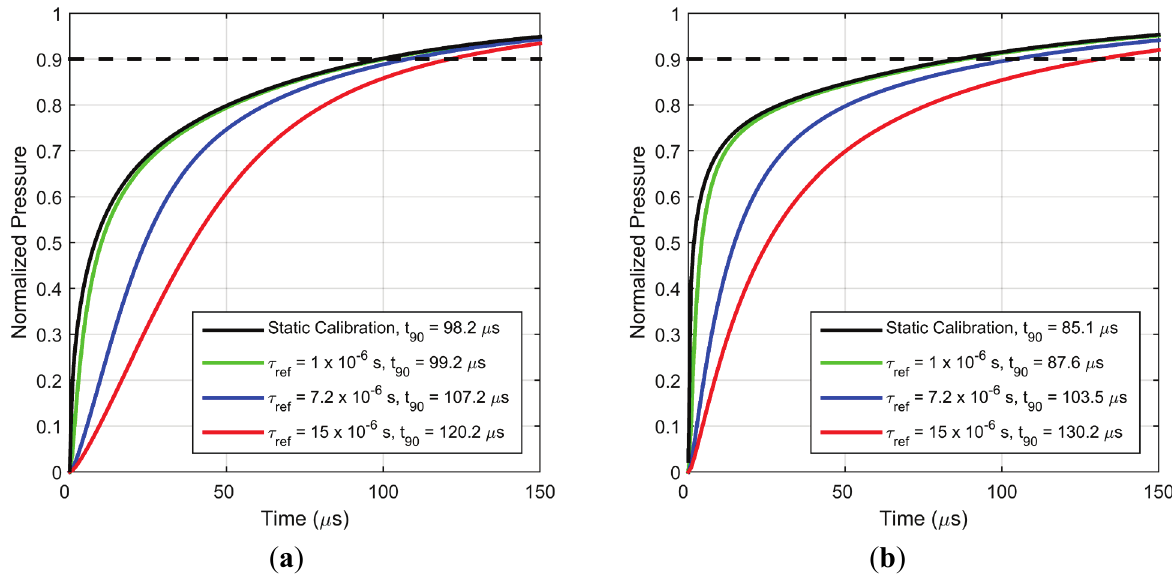
Figure 14. Simulated pressure response for ( a ) step increase in pressure from vacuum to 1 atm. and ( b ) step decrease in pressure from 1 atm. to vacuum, for different values of ambient